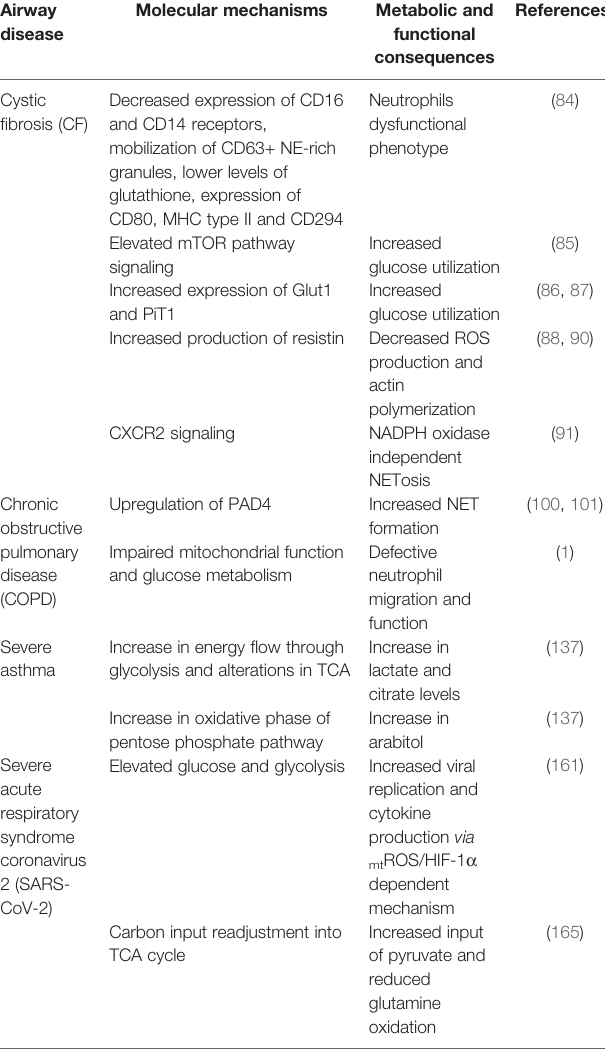
TABLE 1 | Molecular mechanisms and metabolic pathways possibly altered in leucocytes in airway